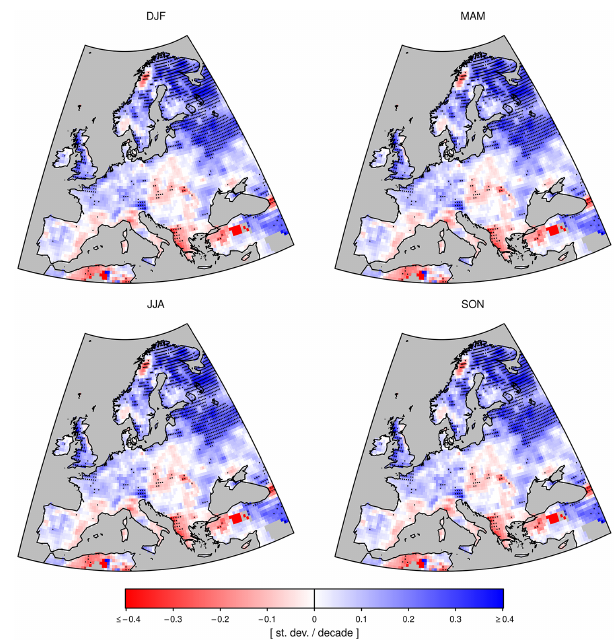
Figure 2. Seasonal patterns in SPI-3 trends. Trend patterns are evaluated for four months, of which the accumulation time cov- ers the respective season. For Winter (DJF), SPI-3 is evaluated for the month of February, which accounts for accumulated precipita- tion in the three winter months (December, January, February). For Spring (MAM), SPI-3 is evaluated for the month May, accounting for accumulated precipitation in March, April and May. For Sum- mer (JJA), SPI-3 is evaluated for August, accounting for accumu- lated precipitation in June, July and August. For Autumn (SON), SPI-3 is evaluated for the month of November, accounting for accu- mulated precipitation in September, October and November. Trends are expressed in units of standard deviations per decade. Stippling indicates local significance ( α local < 0.05). Field significance is re- ported in Fig. 1.